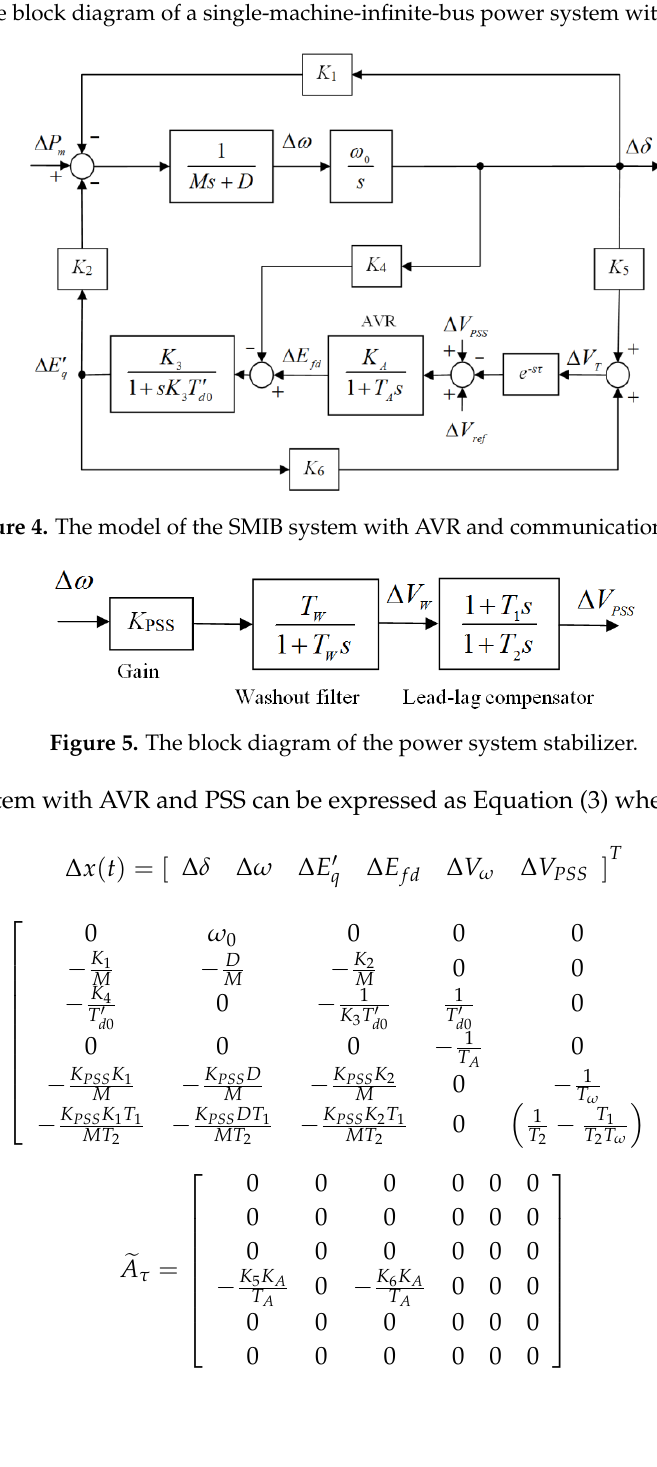
Figure 3. The block diagram of a single-machine-infinite-bus power system with AVR and PSS.